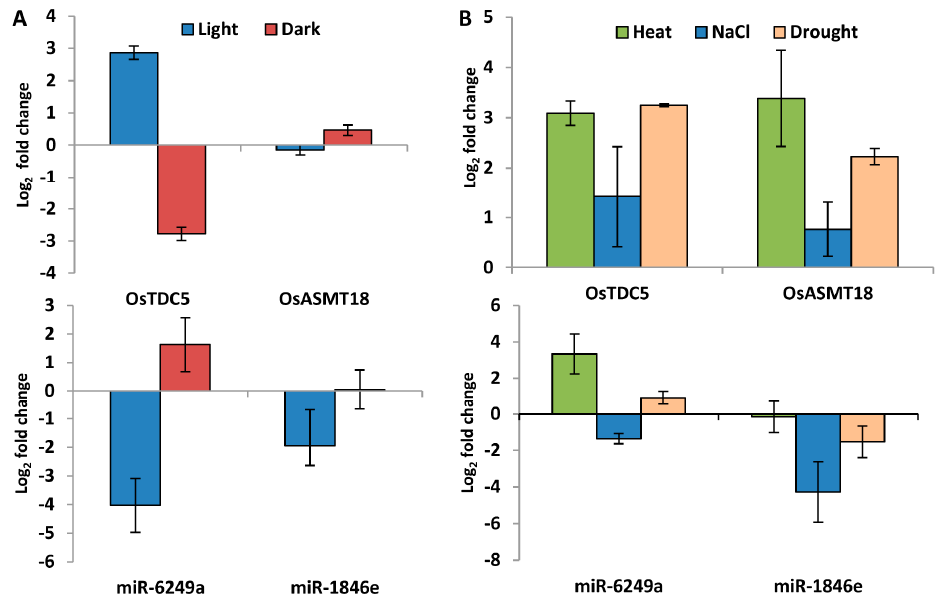
Figure 9. Light/dark and stress-mediated regulation of microRNAs and its corresponding target genes. Expression profiling of OsTDC5 and OsASMT18 and its corresponding miRNA under ( A ) light (100 µ mol/m 2 /s)/dark conditions and ( B ) stress such as exposure to heat (42 ◦ C), salinity (200 mM NaCl) for 6h and drought condition (water withheld) for 24 h.